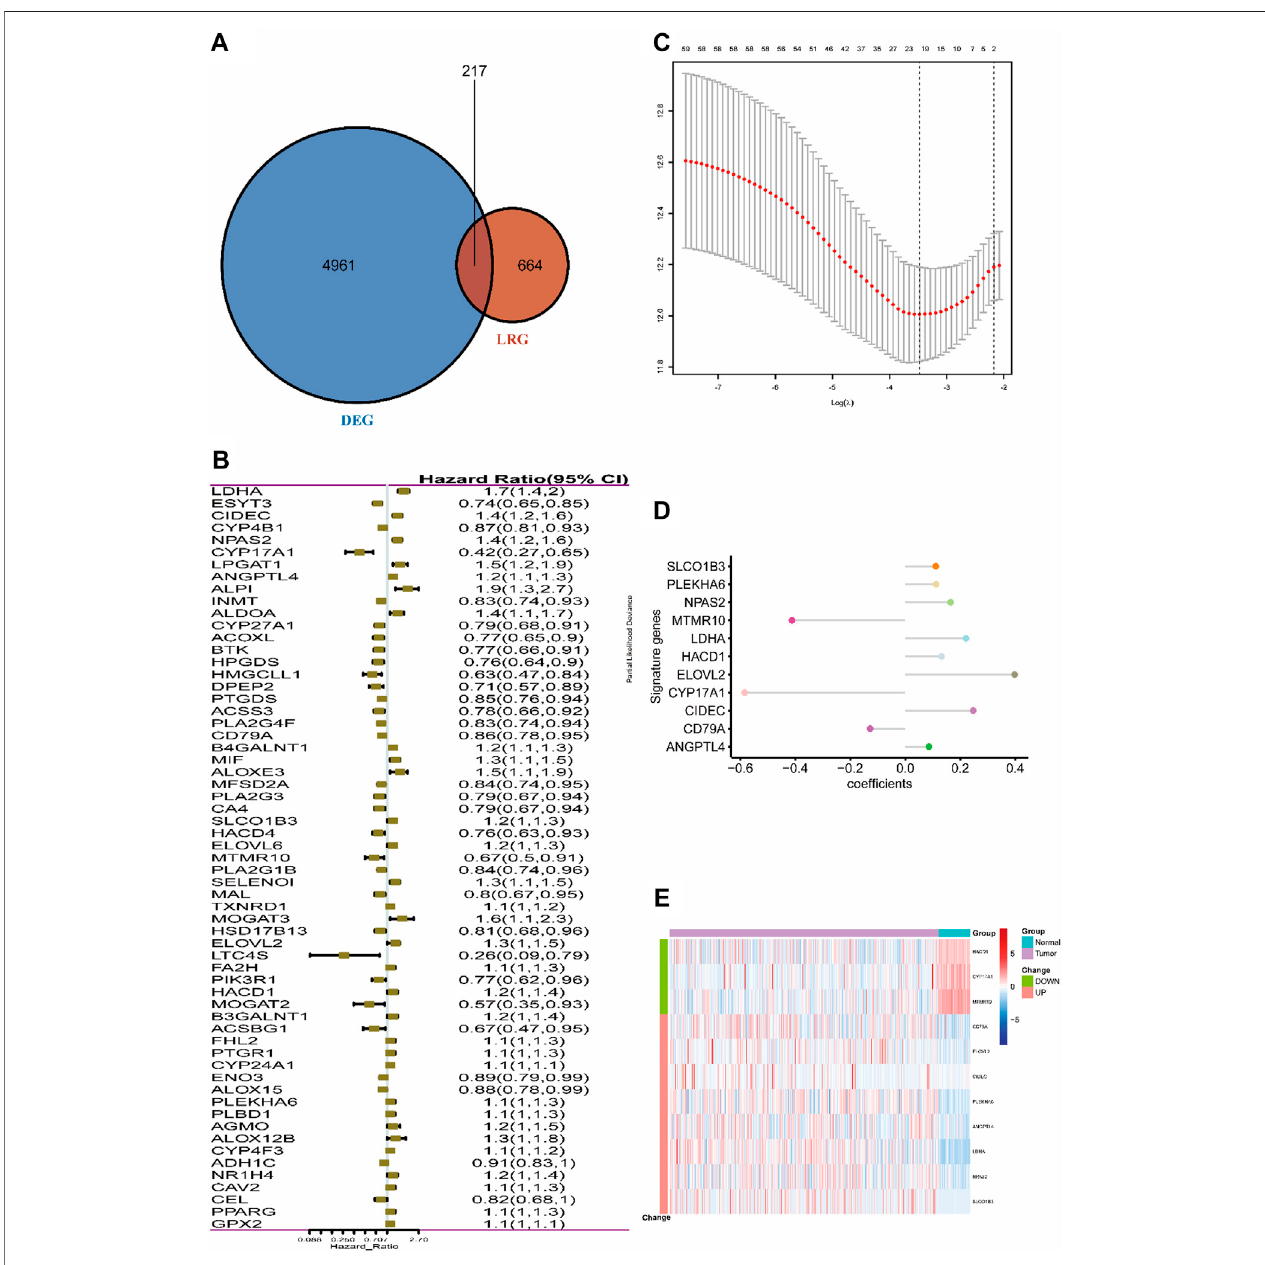
FIGURE2| SelectionofLMRGs associatedwiththesurvivaloflungadenocarcinoma. (A) Venndiagramshowstheintersection ofDEGsand LRGs. (B) Forest plot of LMRGs associated with TCGA-LUAD survival. (C) Selection of the optimal parameter (lambda) in the LASSO Cox model for TCGA-LUAD. (D) LASSO coef fi cients of the 11 hub genes in TCGA-LUAD. (E) Heatmap of top 11 hub genes in TCGA-LUAD. “ Group ” means the tumor or adjacent tissues of TCGA-LUAD samples, while “ Change ” represents the expression trend of 11 lipid metabolism-related genes in tumor tissues when compared with adjacent tissues. DEG, differentially expressed gene; LMRG, lipid metabolism-related gene. Construction of the 11-LRG-based prognostic model in the TCGA-LUAD cohort.